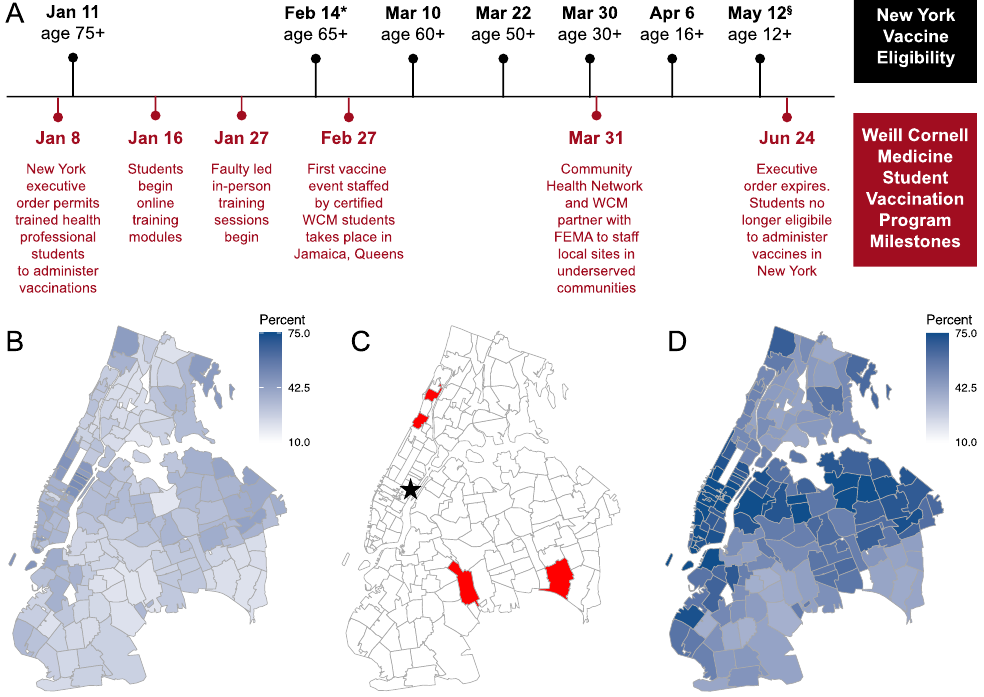
Figure 1. Timeline and map of student vaccination program in 2021 ( A ) New York State COVID-19 vaccine eligibility dates (top, black) superimposed with summary of key events of WCM vaccination program (bottom, red). Note timeline not drawn to scale. * Vaccine eligibility also extended to people with underlying medical conditions on February 14. § People ages 12 – 15 were exclusively eligible for the Pfizer-BioNTech COVID-19 vaccine. ( B ) Heatmap of NYC vaccination status, at least one dose by 26 March 2021. ( C ) Locations of WCM vaccination program sites (red) and Weill Cornell Medicine (star). ( D ) Heatmap of NYC vaccination status at least one dose, by 1 July 2021, as colored in ( B ).